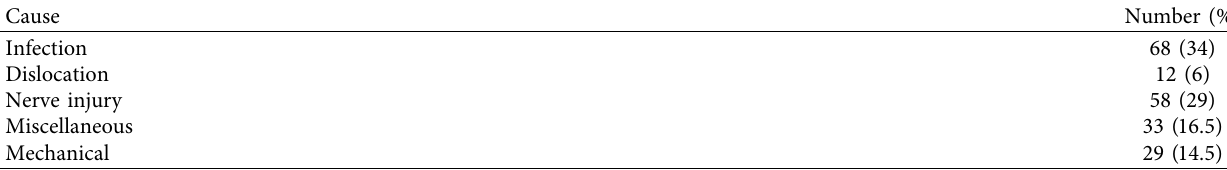
Table 1: The cause for reimbursement among the 200 scanned patients.